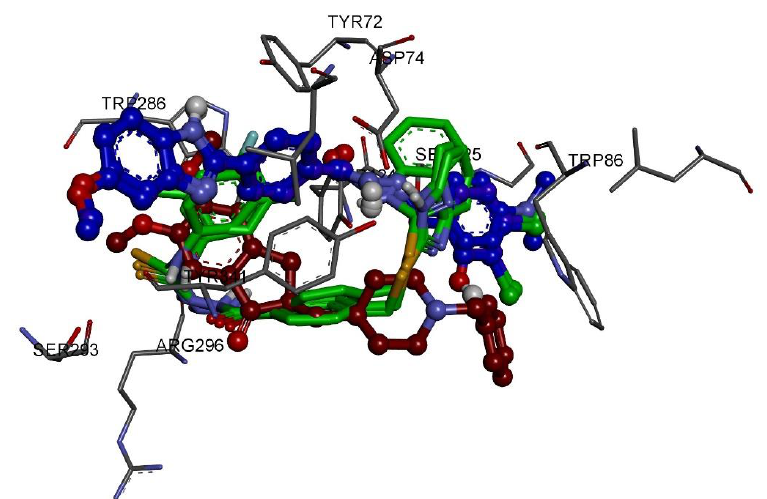
Figure 2. Docked poses of the best active benzimidazole thiosemicarbazides ( 1c , 1b, and 1g blue color representations), benzimidazole Schiff bases ( 2c , 2h, and 2e green color representations) and donepezil (brown color representation) into the active binding site of acetylcholinesterase.